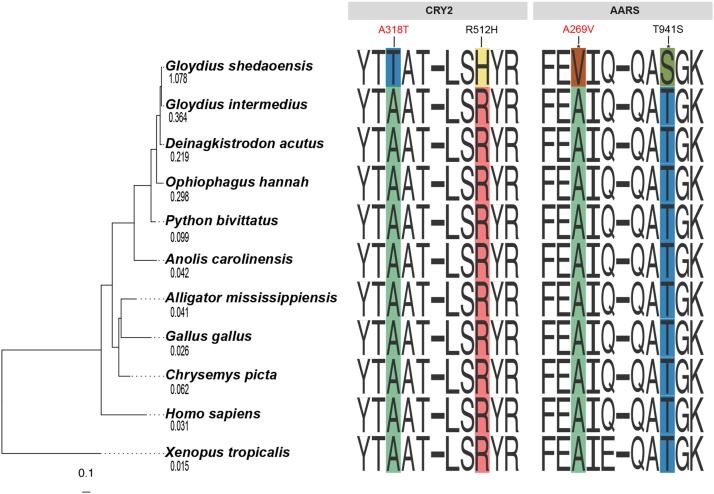
A phylogeny inferred from a maximum likelihood analysis of partitioned fourfold degenerate sites. Numbers under species name are estimated dN/dS ratios for CRY2. Four Shedao pit-viper specific amino acid substitutions in the CRY2 and AARS genes are identified. A318T and A269V (in red) are predicted to affect protein functions and A269V and T941S (with asterisks) are under positive selection.